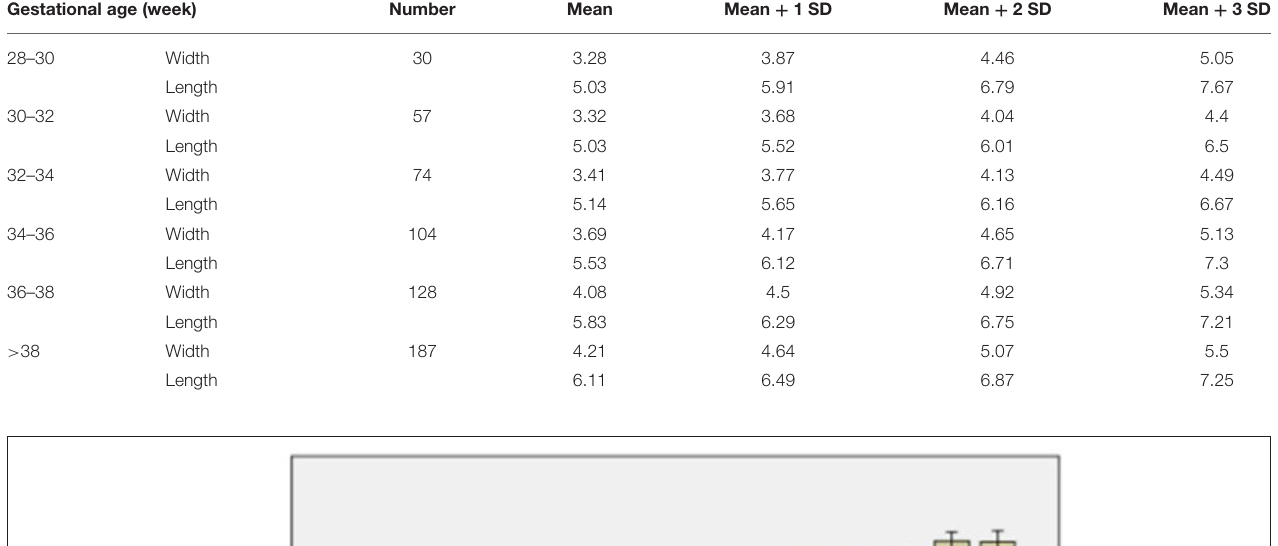
TABLE 1 | Mean and SD of clitoral width and length based on different gestational ages of neonates. Gestational age (week)